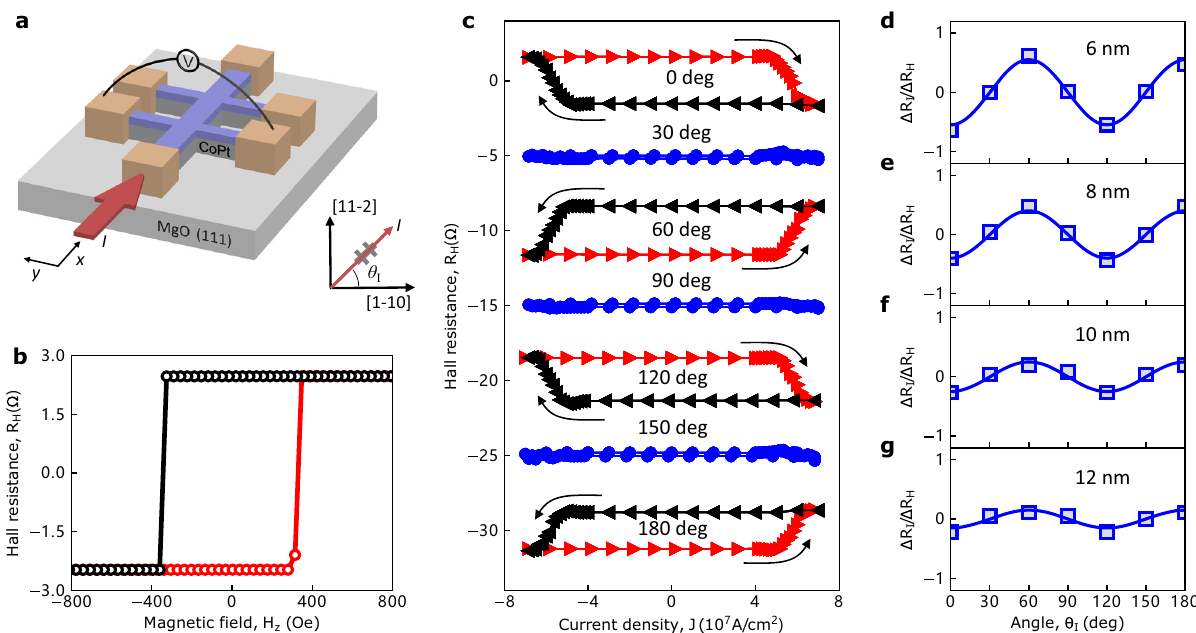
Fig. 2 Field-free magnetization switching in Co 30 Pt 70 single layers on MgO (111) substrate. a Schematic of the Co 30 Pt 70 Hall bar device for electrical transport measurement. b Anomalous Hall effect of the 6 nm Co 30 Pt 70 sample. c Current-induced fi eld-free magnetization switching in Co 30 Pt 70 for Hall bars with different θ I . The loops are manually shifted for better visualization. d – g θ I dependence of Δ R I / Δ R H for Co 30 Pt 70 devices with different thicknesses (6, 8, 10, and 12 nm).